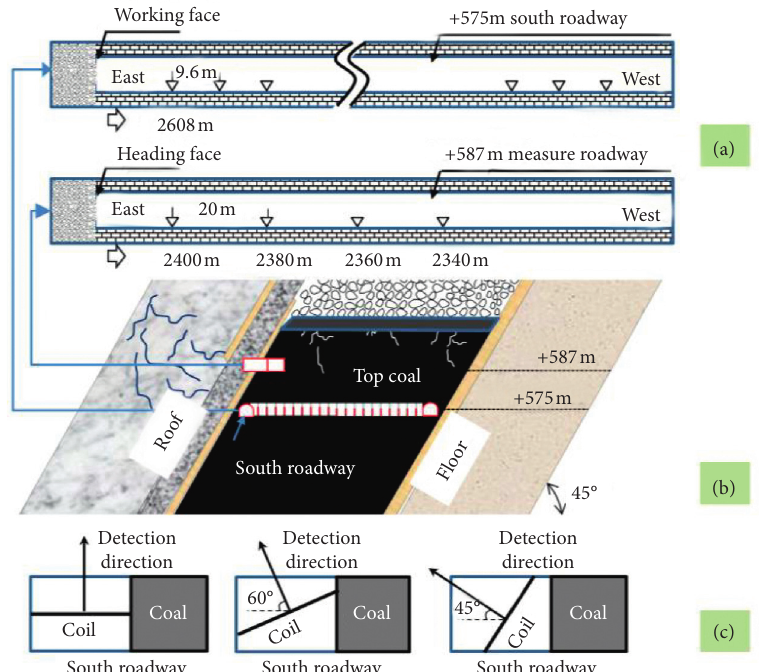
Figure 7: TEM monitoring scheme: (a) location of measuring points; (b) construction site; (c) angle of